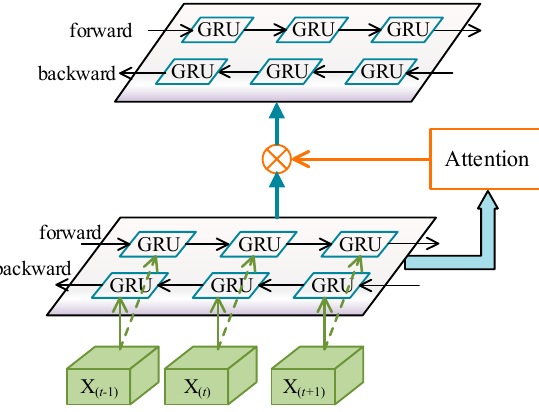
Figure 4. The structure of the attention memory module.